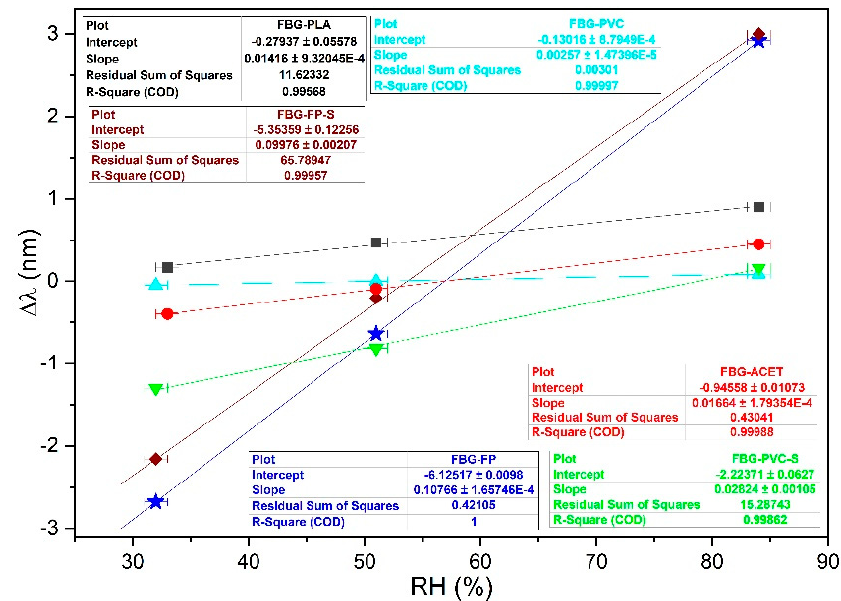
Figure 5. Experimental data (dots) and linear fits (lines) providing the sensitivities listed in Table 1: FBG-PLA (square); FBG-ACET (dot); FBG-PVC (up-triangle); FBG-PVC-S (down-triangle); FBG-FP (star); FBG-FP-S (diamond).